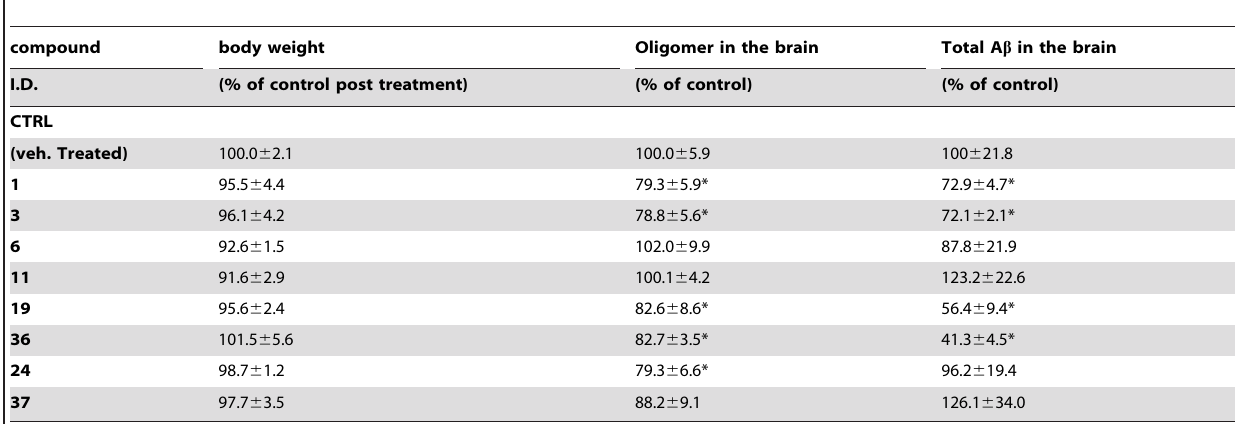
Table 1. Short-term feasibility studies of the 8 lead compounds in reducing A b neuropathology in Tg2576 mouse model of AD.